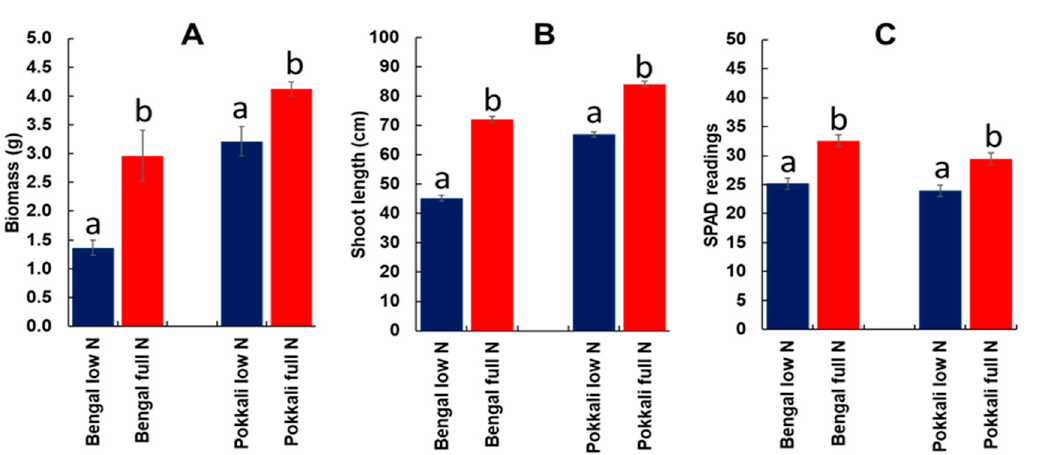
Figure 2. Biomass ( A ), shoot length ( B ), and ( C ) chlorophyll content (SPAD readings) in Pokkali and Bengal under low nitrogen (4 ppm) and full nitrogen (40 ppm) in a hydroponic experiment. Means with similar letters indicate no significant difference at p < 0.05 ( n = 15) determined using a one-way ANOVA. Changes in root architecture under nitrogen starvation was evident in Pokkali and Bengal (Table 1 and Figure 3). The response to N stress (low N) lead to an increased lateral root length, total number of roots, total root surface area, and root volume except for root diameter / thickness in both genotypes. The root attributes were more pronounced in Pokkali compared with Bengal under normal and low N. The root length and root counts were positively correlated with the total root surface area and root volume (Table S1 and Figure S2). Table 1. Root architecture measurements of Pokkali and Bengal in low and full N. Average Lateral Genotype Treatment Root Length